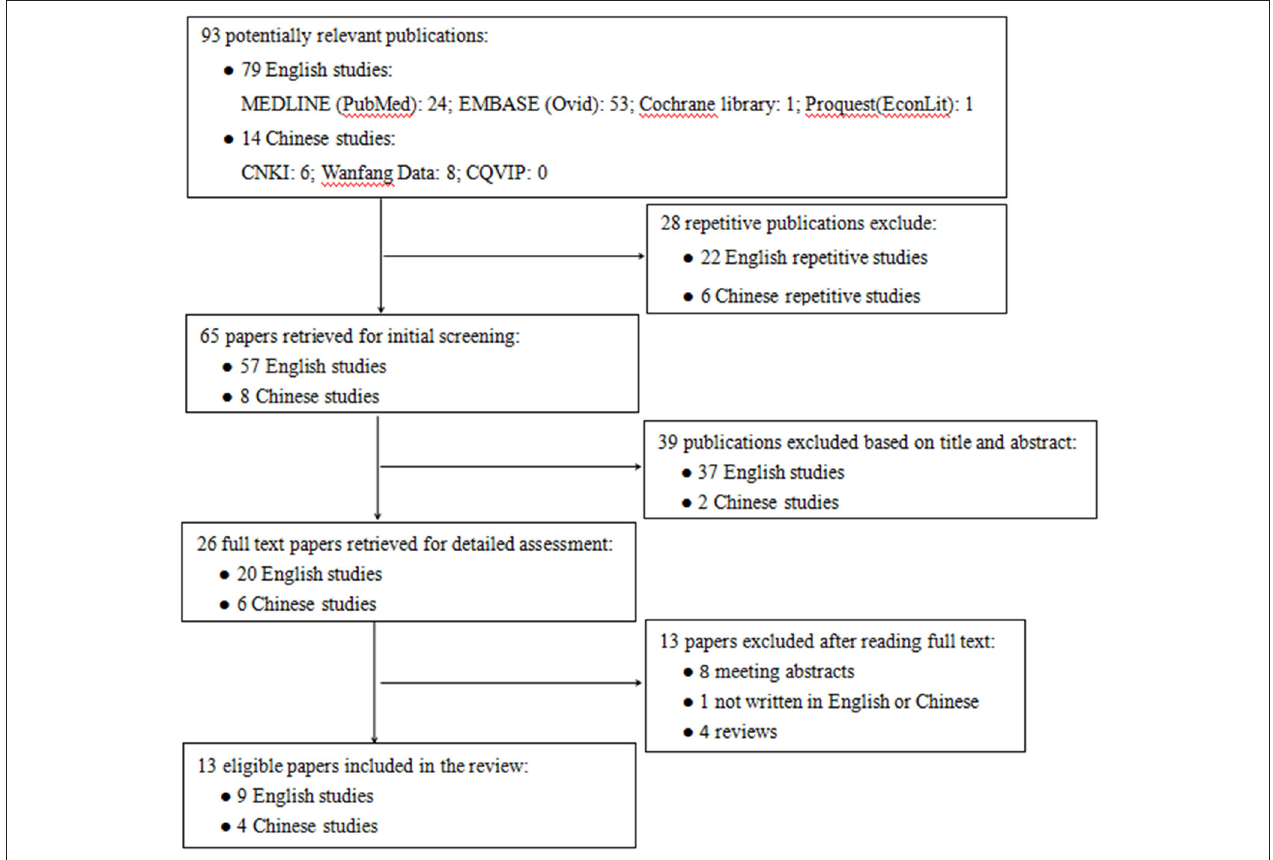
FIGURE 1 | Flowchart of literature search. CNKI, China National Knowledge Infrastructure database; CQVIP, Chongqing VIP